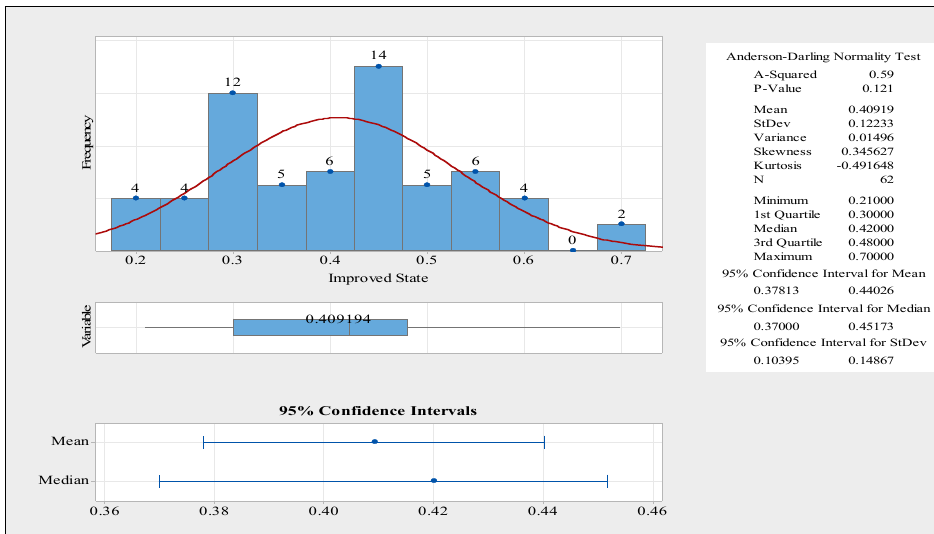
Figure 11. Summary report for the physician waiting time in the improved state.